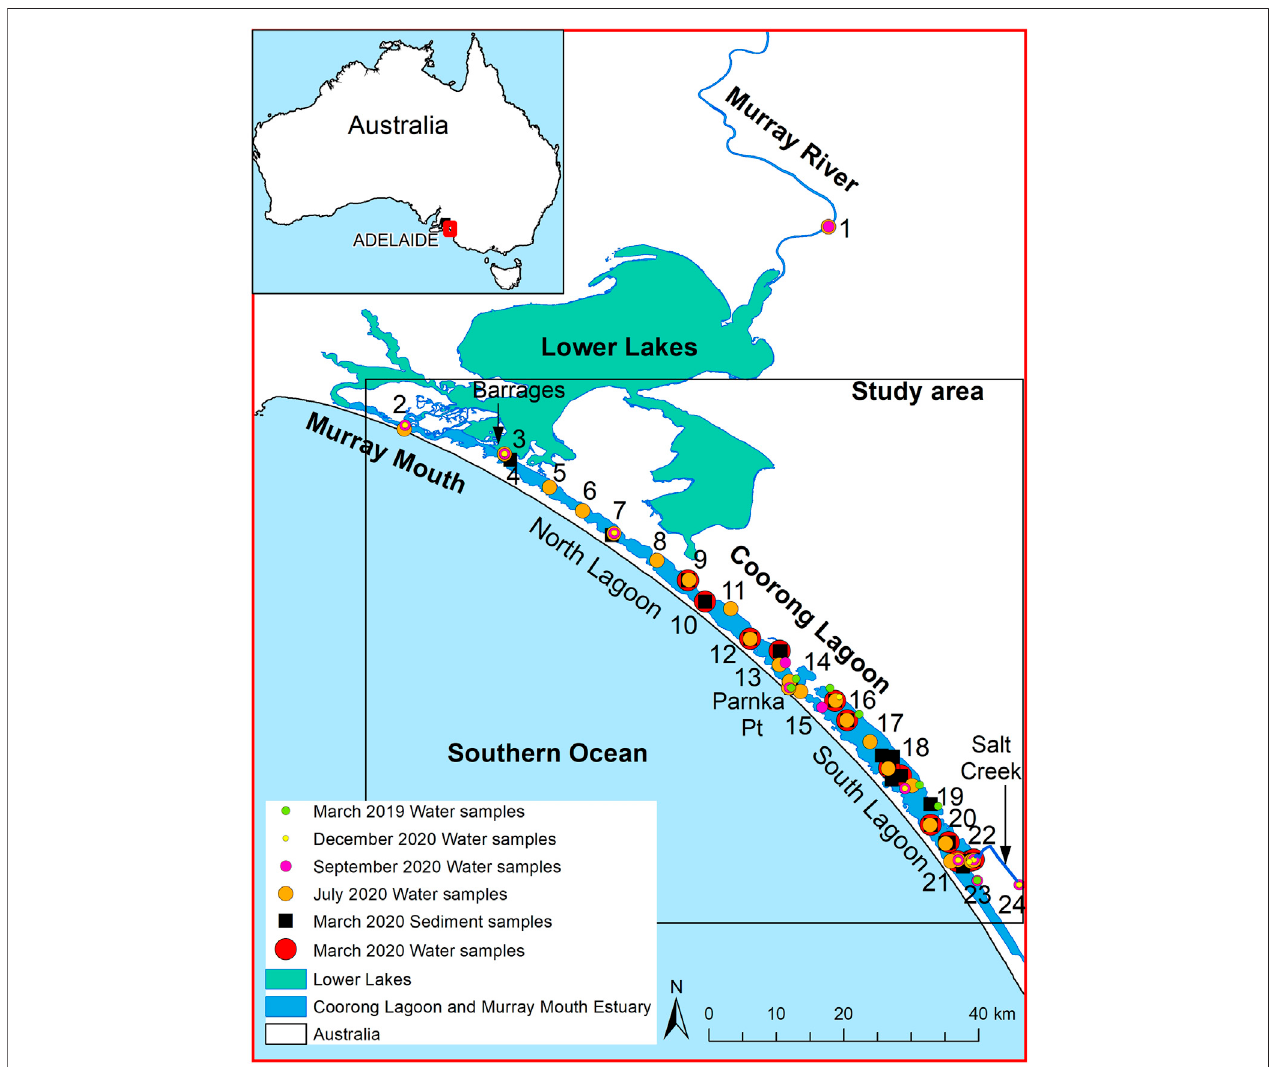
FIGURE1| MapoftheCoorongLagoonincludinglocationofwaterandsedimentsamplingsites.ParnkaPointislocatedatsitenumber14andPoliceman ’ spointis located at site number 19.